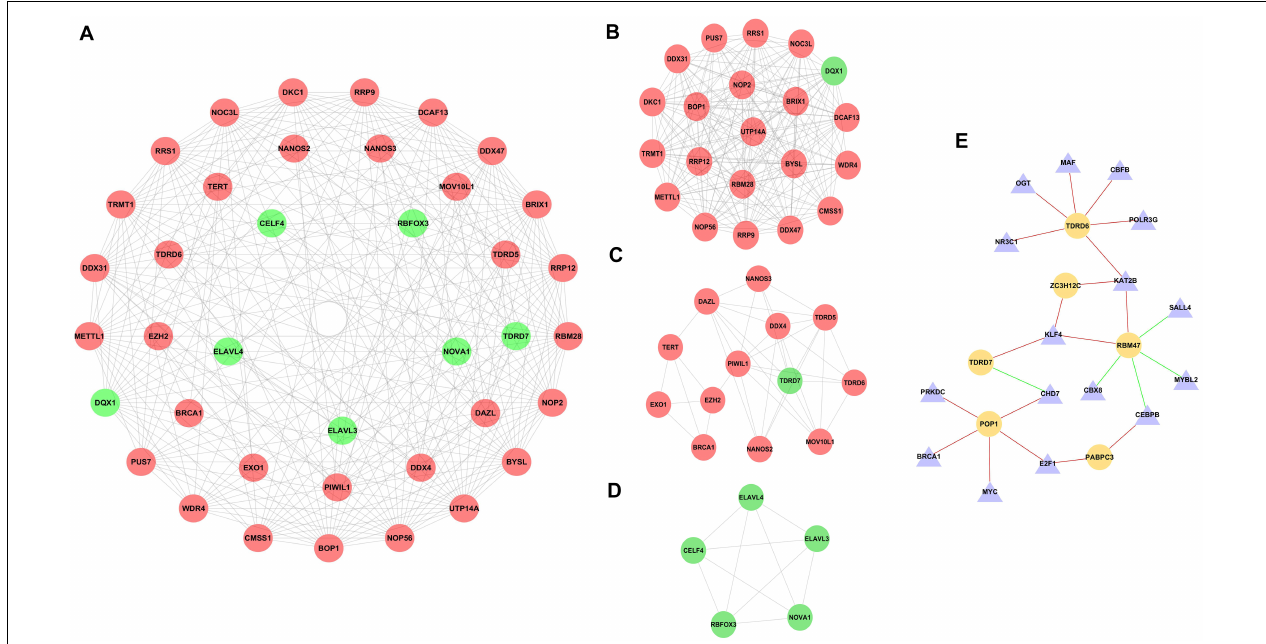
FIGURE 3 | PPI network of differentially expressed RBPs (DE RBPs) and regulatory network based on DE transcription factors and prognostic DE RBPs. (A) PPI network including three modules. The three circles from the inside out represent three modules. (B) Module 1 in PPI network. (C) Module 2 in PPI network. (D) Module 3 in PPI network. (E) Regulatory network between DE TFs and prognostic DE RBPs. The triangle represents TF, and the cycle represents prognostic DE RBP. The red line represents positive regulation, whereas the green line represents negative regulation.